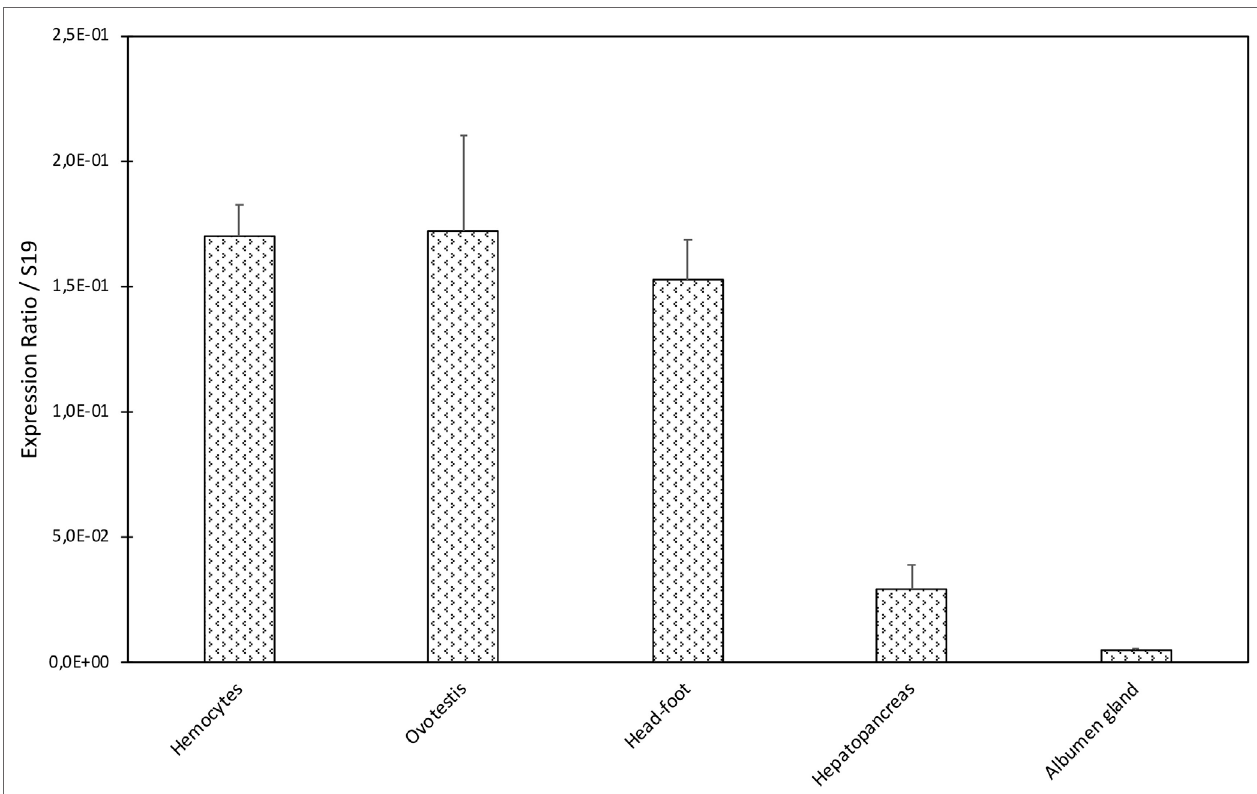
FigUre 3 | Tissue expression of BgTEP. Transcription profile of BgTEP in different tissues extracted from 9 to 10 snails. Five snail tissues are dissected: albumen gland, hepatopancreas, head-foot, and ovotestis. Hemocytes were collected from 50 snails. Quantitative RT-PCR was performed on total RNA. C t values of the BgTEP transcript were normalized to the transcript level of the reference gene S19. Error bars represent the SD of the Δ C t mean values obtained for each tissue. Asterisks indicate a significant expression difference between mentioned